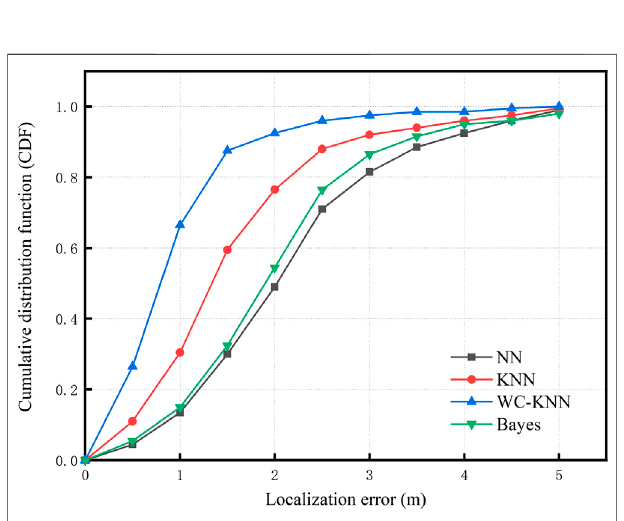
FIGURE 5 | Cumulative error distribution function diagram of four different algorithms. The performance of WC-KNN algorithm was the best, its median location error was 0.8 m. The median location errors of KNN, Bayes, NN were 1.2, 1.8, 2.1 m respectively.